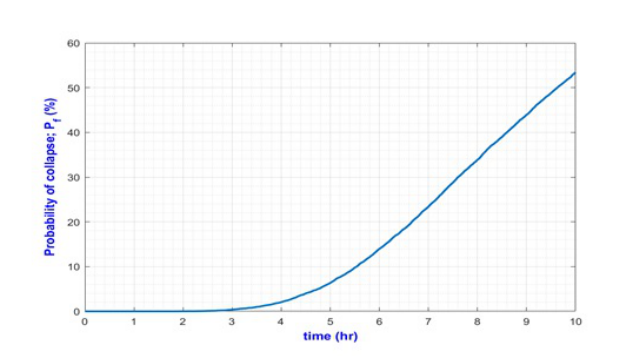
Figure 15. Probability of bluff collapse during a storm.